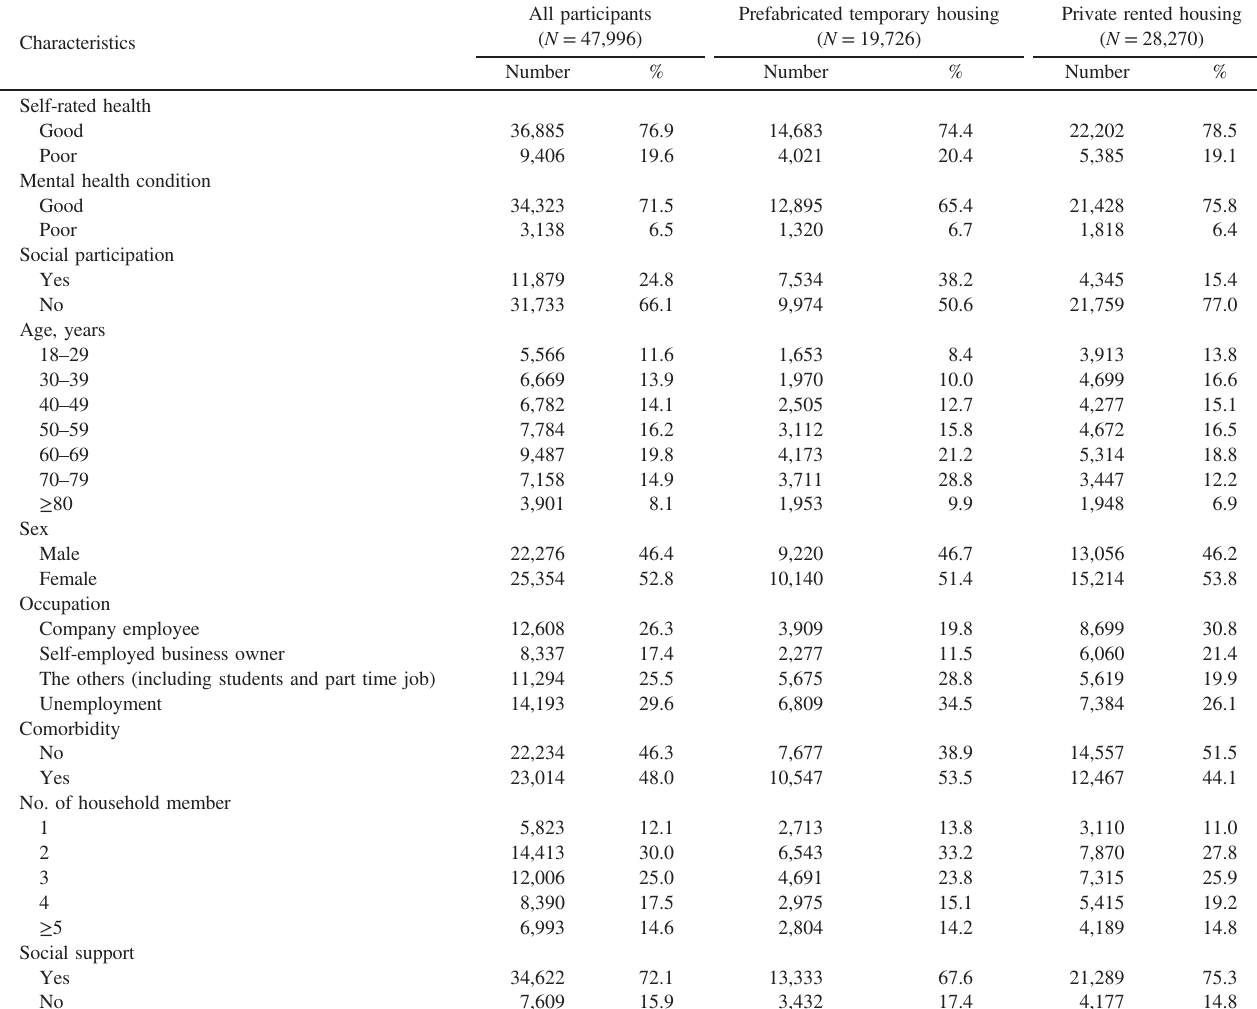
Table 1. Characteristics of participants in prefabricated housing and rented housing a